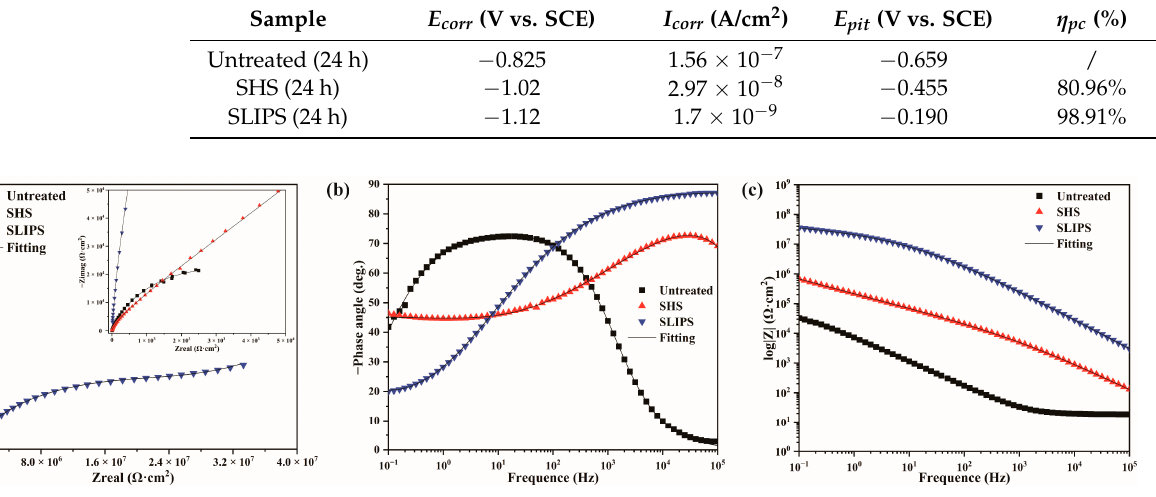
Figure 9. EIS after immersion in simulated seawater for 24 h: ( a ) Nyquist plots; Bode plots of ( b ) phase angle vs Frequency and ( c ) |𝑍| vs Frequency for the three samples. Table 4. Electrochemical parameters obtained from EIS simulation with equivalent circuit after immersion in simulated seawater for 24